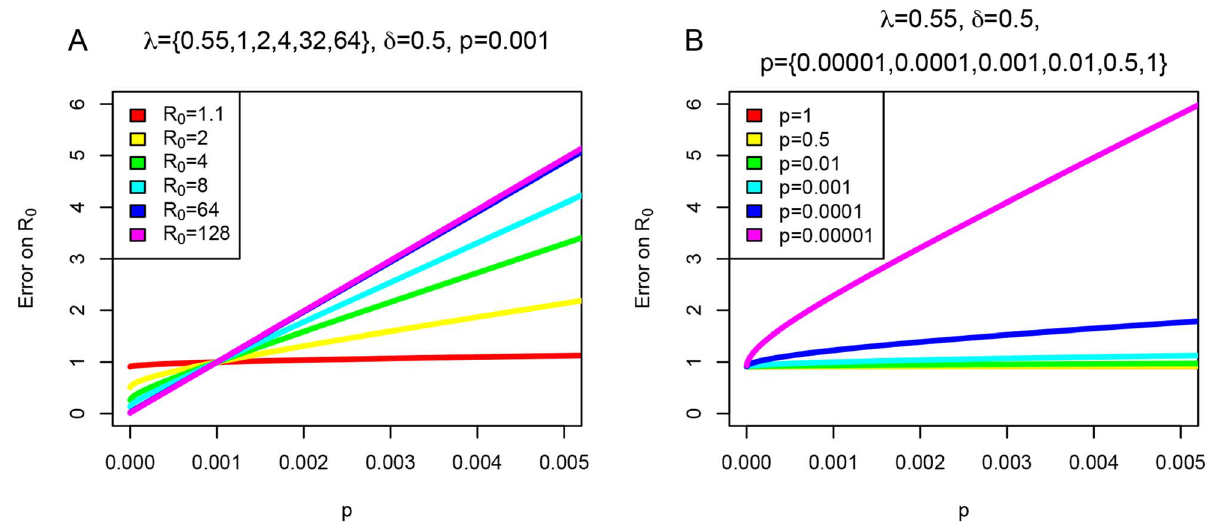
Figure 4. Error on R 0 as a function of sampling probability p for fixed l { d and ld p . In (A) the relationship between the error on R 0 , i.e. estimated R 0 /true R 0 , and the sampling probability p is plotted. The values r ~ l { d and d ~ ld p are fixed. For different R 0 , R 0 ~ f 1 : 1,2,4,8,64,128 g , and d ~ 0 : 5 and p ~ 0 : 001 , we calculate r and d , and plot the impact on R 0 error when changing p during inference using Equation (3) in the Supplementary Material S1. In (B) we display how error on R 0 depends on different assumptions of p during inference for R 0 ~ 1 : 1 , and d ~ 0 : 5 and an array of true sampling probability p ~ f 0 : 00001,0 : 0001,0 : 001,0 : 01,0 : 5,1 g used for calculating r and d